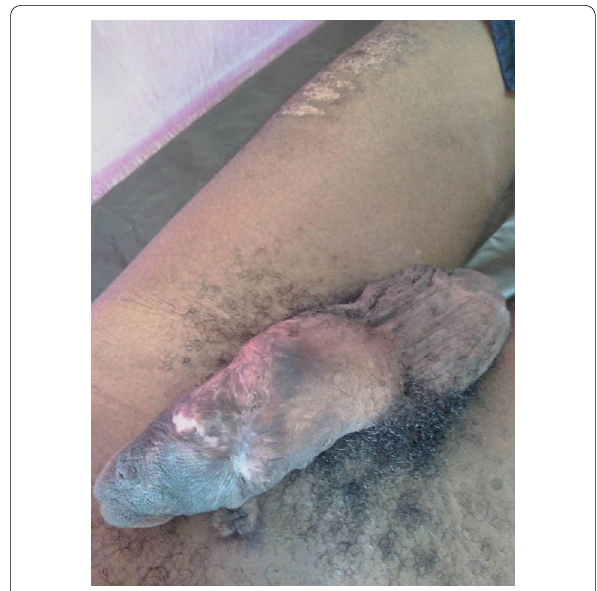
Fig. 4 Penile GSW showing satisfactory take of penile skin graft and absence of penile